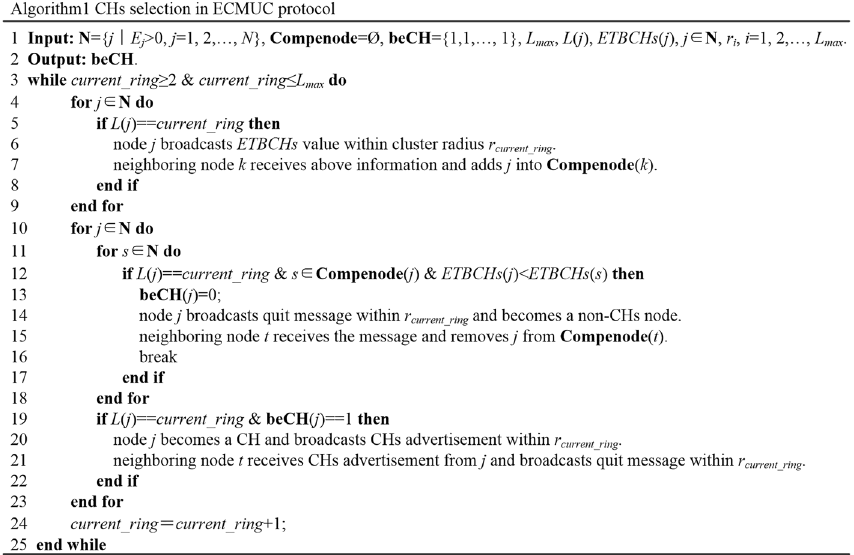
Figure 4. Pseudo code of CHs selection in ECMUC